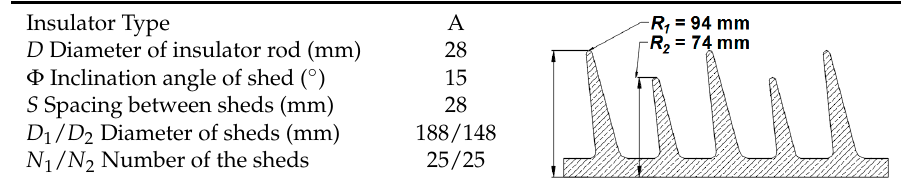
Table 1. Parameters of the tested insulator.